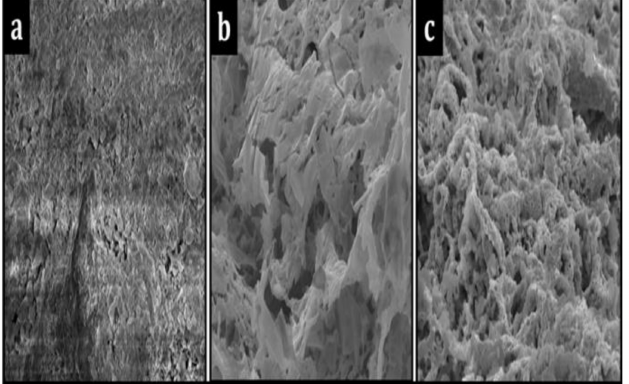
Figure 6. SEM image of fresh catalysts: ( a ) CsNi 0.9 Zr 0.1 O 3 ; ( b ) CeNi 0.9 Zr 0.1 O 3 ; ( c ) LaNi 0.9 Zr 0.1 O 3